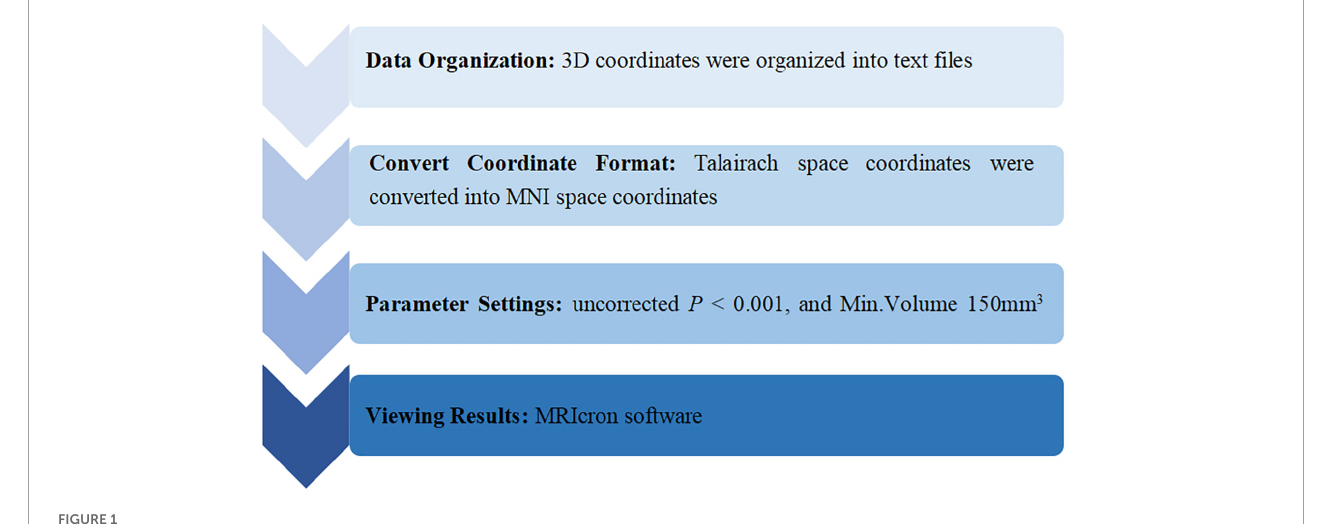
FIGURE1 The process of ALE